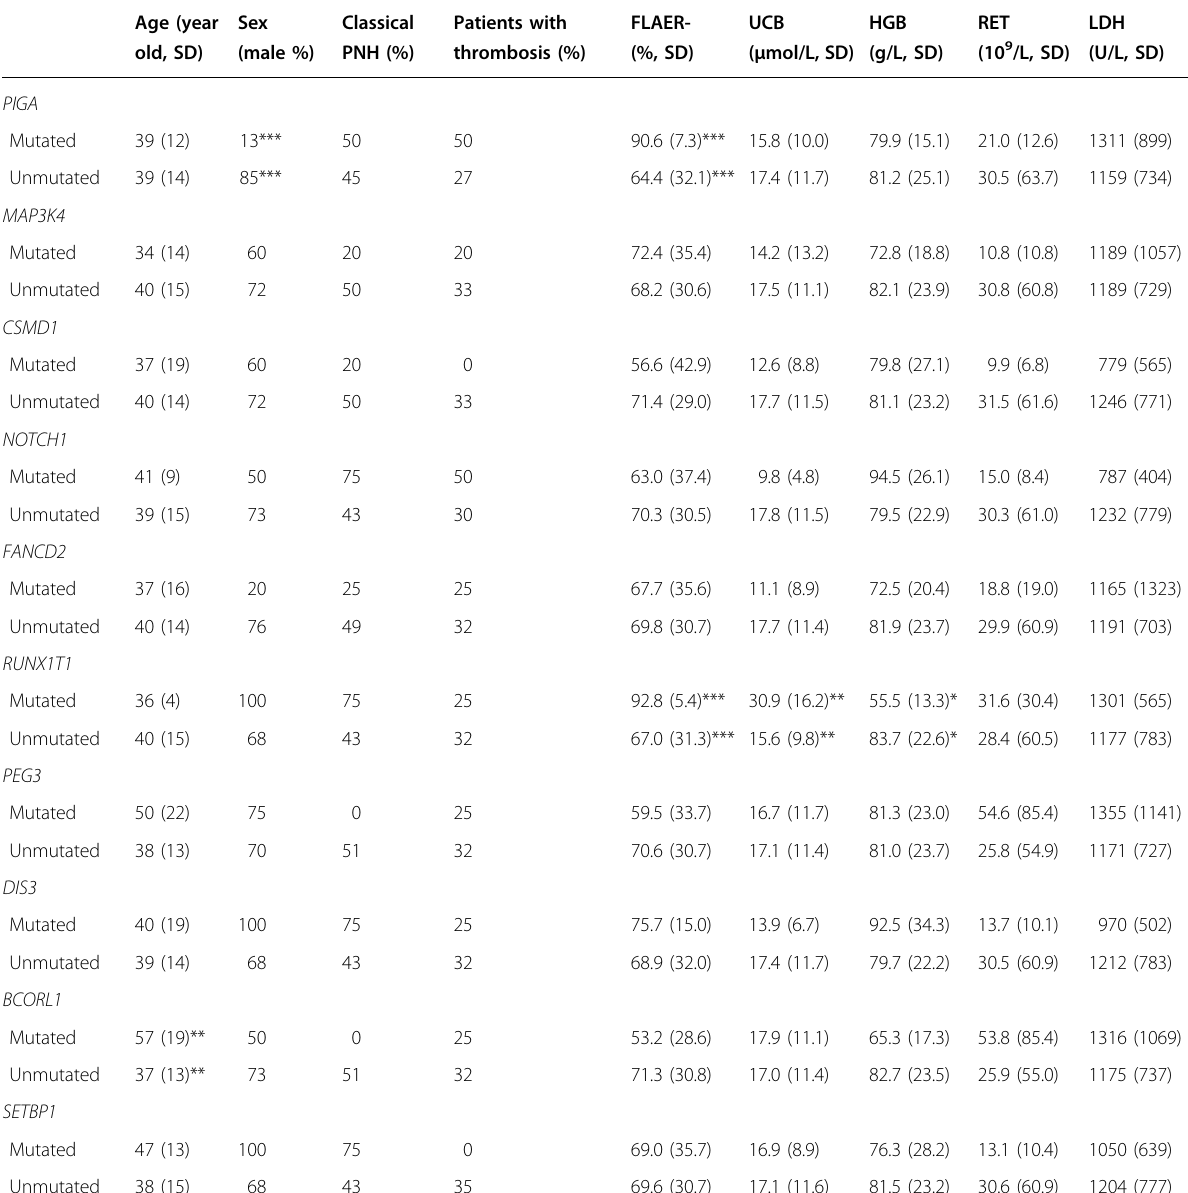
Table 1 Correlation of common mutations with clinical and laboratory features in